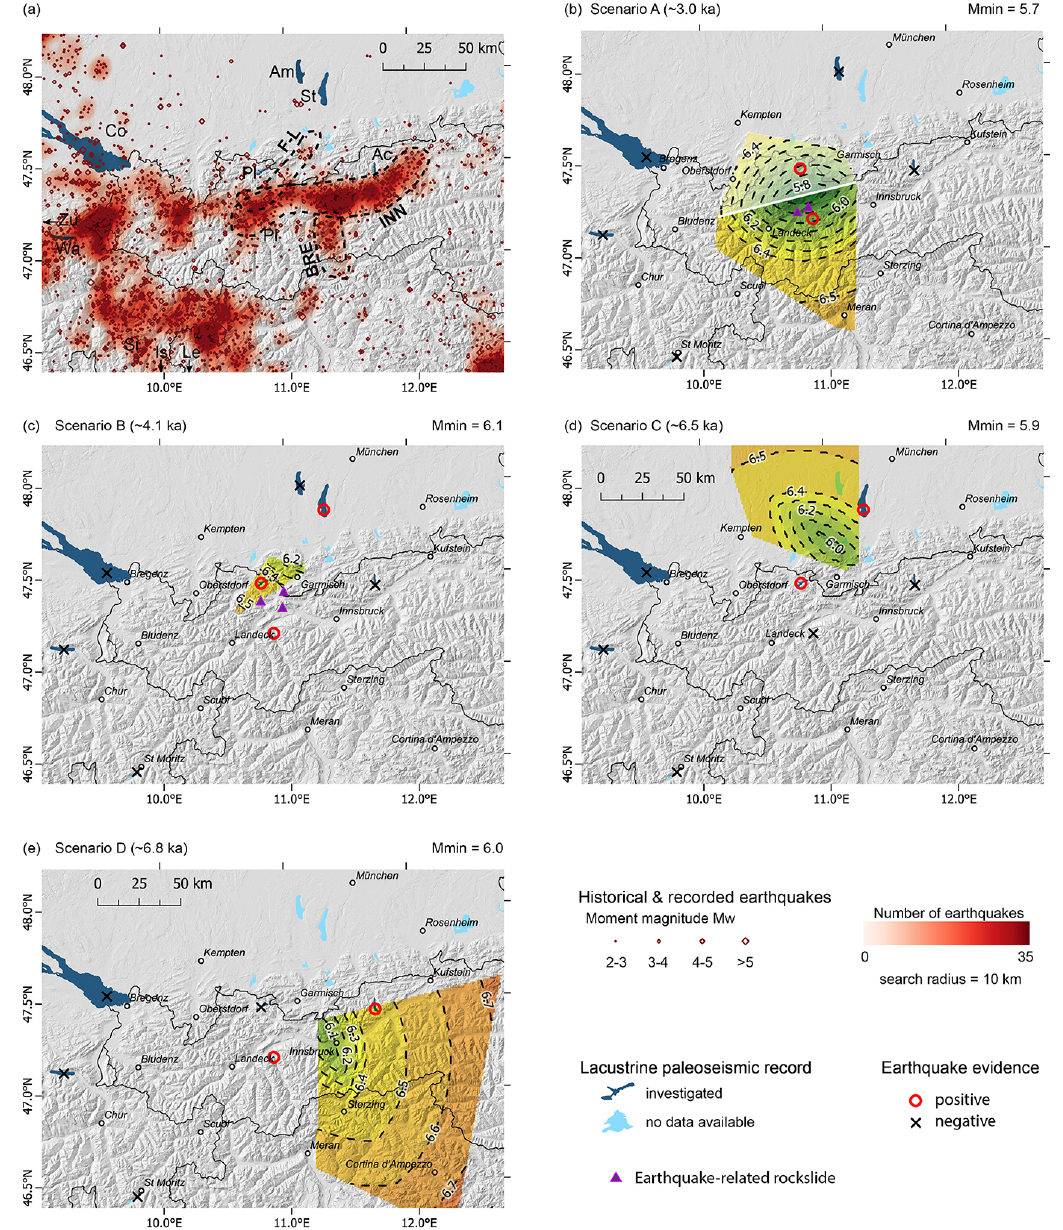
Figure 6. Magnitude and source area estimations of plausible paleo-earthquake scenarios with consideration of positive and negative earth- quake evidence at multiple sites reversely using an IPE in a grid-search analysis (Strasser et al., 2006; Kremer et al., 2017, after Bakun and Wentworth, 1997). (a) Map with historical and instrumentally recorded earthquake data (Reiter et al., 2018; Stucchi et al., 2013); zones of present-day enhanced seismicity (dashed lines) around the Inn valley (INN), the Brenner Pass (BRE), and the Fernpass–Loisach region (F– L). The lacustrine event records investigated for the scenario modeling are Achensee (Ac; Oswald et al., 2021a), Ammersee (Am; Czymzik et al., 2013), Lake Constance (Co; Schwestermann, 2016), Lake Iseo (Is; Lauterbach et al., 2012), Lake Ledro (Le; Simonneau et al., 2013), Piburgersee (Pi; Oswald et al., 2021b), Plansee (Pl; Oswald et al., 2021b), Silvaplanasee (Si; Bellwald, 2012), Starnbergersee (St; Daut, 1998), Walensee (Wa; Zimmermann, 2008), and Lake Zürich (Zu; Strasser and Anselmetti, 2008; Strasser et al., 2013). (b–e) Calculated plausible source areas and minimum magnitudes for paleo-earthquakes with assumed coeval positive earthquake evidence in more than one lake at (b) ∼ 3 . 0ka, (c) ∼ 4 . 1ka, (d) ∼ 6 . 5ka, and (e) ∼ 6 . 8ka. In (b) and (c) the interpreted earthquake-related rockslides are indicated as violet triangles (Oswald et al., 2021b). Note that in (b) the transparent source area north of the white line is less likely due to the relatively large sedimentary imprint in Piburgersee compared to Plansee, and the earthquake-triggered rockslides further support this interpretation. Hence, the estimated source area is interpreted more in the south with a minimum magnitude of M w 5.8, which is also used for further considerations and